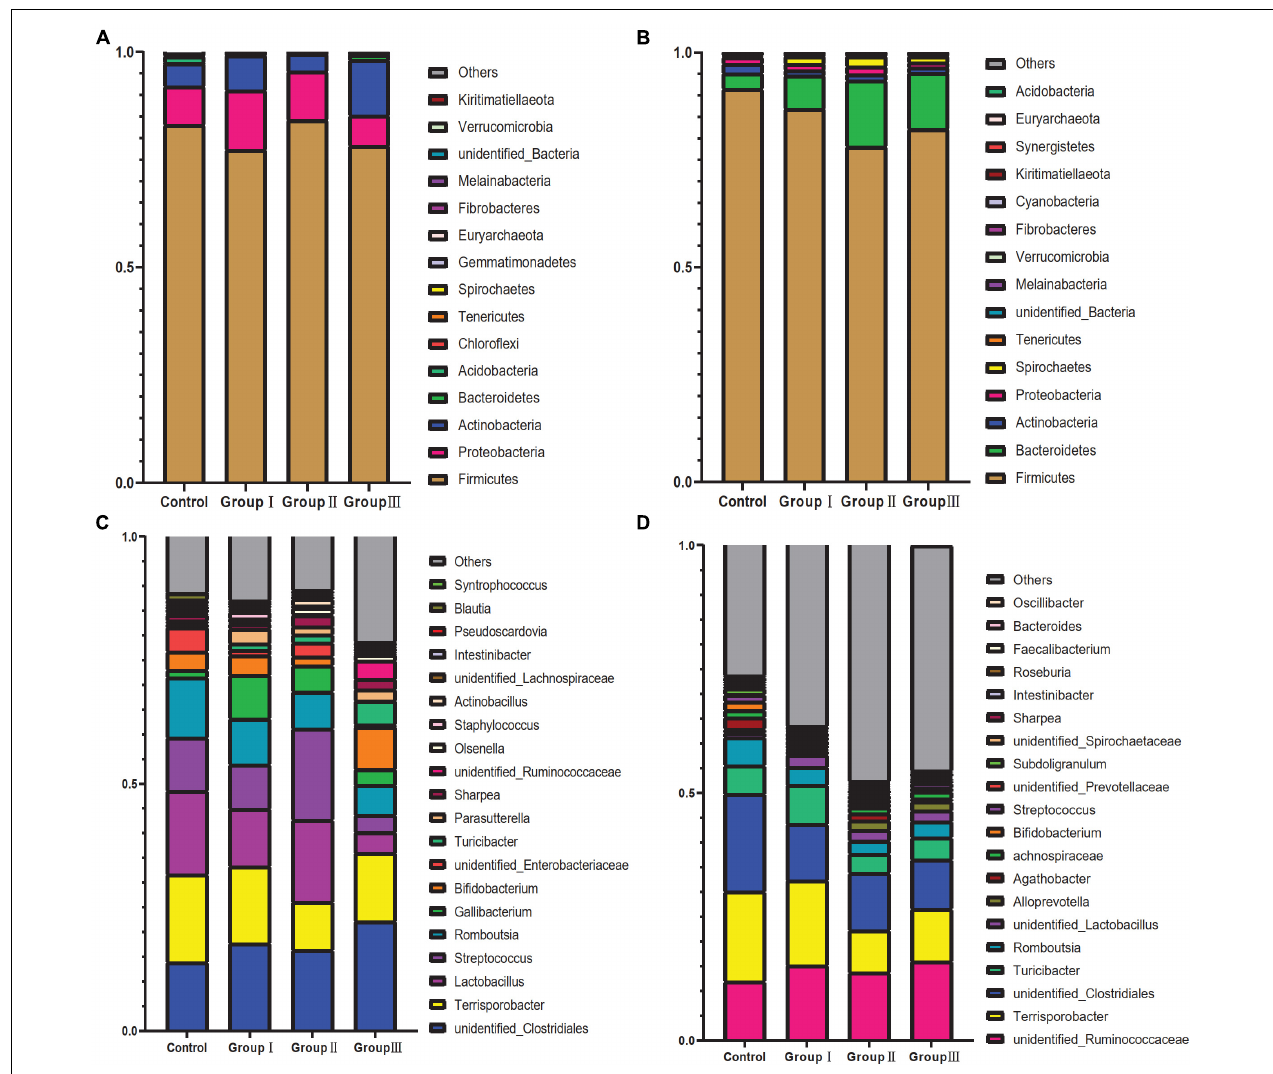
FIGURE 1 | Taxonomic composition of gut bacteria of four dietary fiber groups from jejunal and cecal content samples. The relative abundance of the 15 most abundant bacterial phyla from jejunal content samples (A) and cecal content samples (B) . The relative abundance of the 20 most abundant bacterial genera from the jejunal content samples (C) and cecal content samples (D)